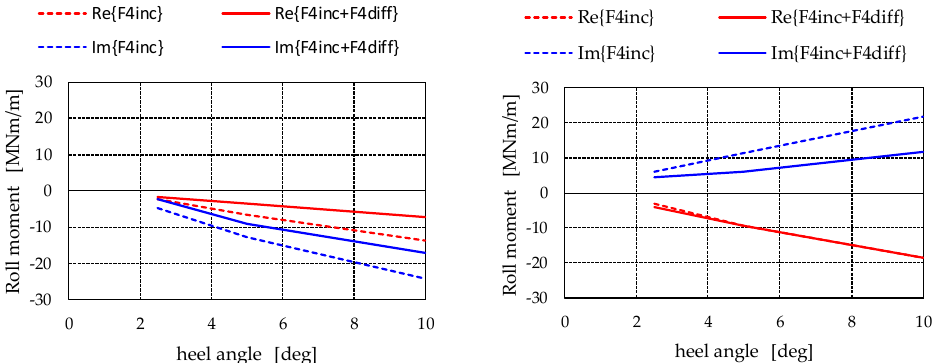
Figure 16. Roll moment due to incoming wave only, and due to incoming + diffracted wave as a function of the initial heel angle. The moment has been split into two components; one component in-phase with the roll motion, Re{F4}, and the other component in-phase with the roll velocity, Im{F4}. Left: Results are for KCS, LC-1, ω 0 = 0.45 rad/s, Hd = 180° and Vs = 8 kn; Right: KCS, LC-12, ω 0 = 0.45 rad/s, Hd = 0° and Vs = 8 kn.